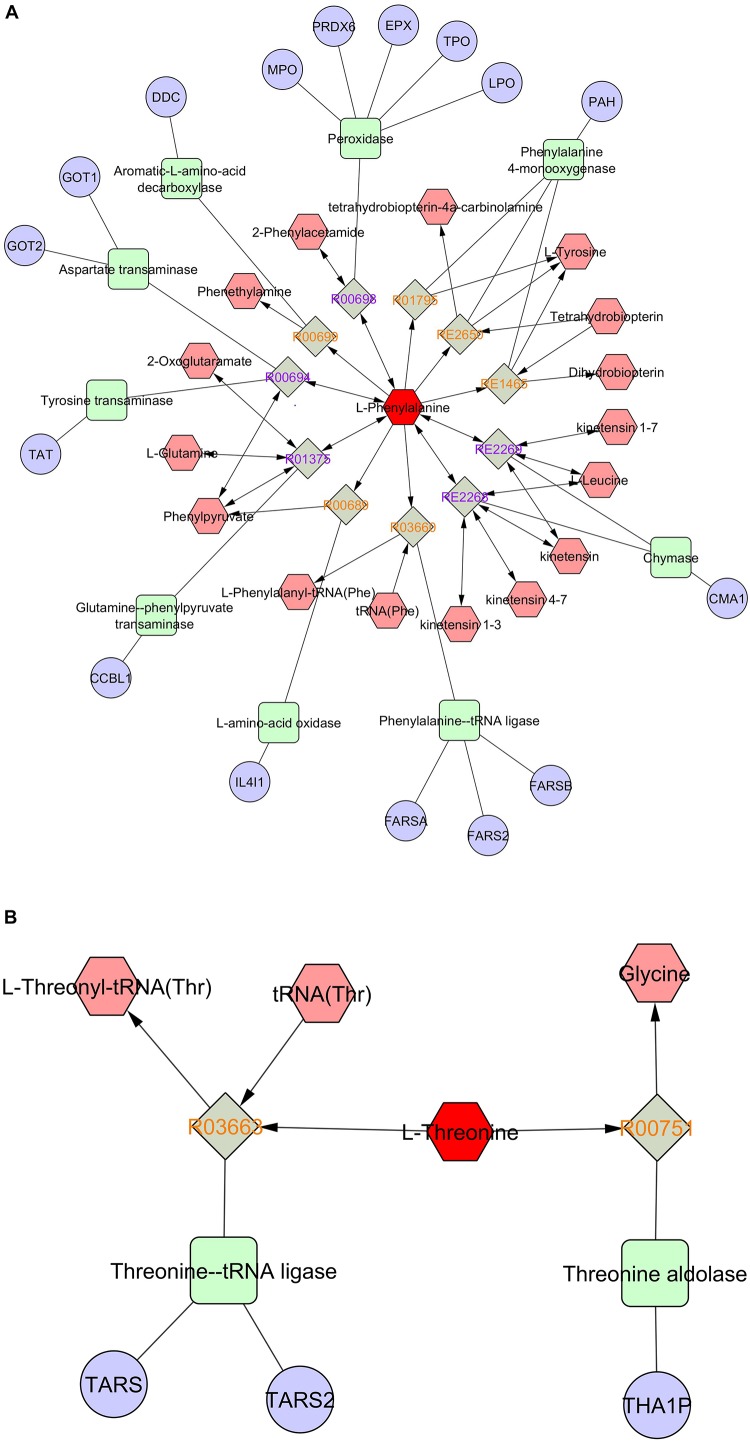
NOTHINGCOMESHERE